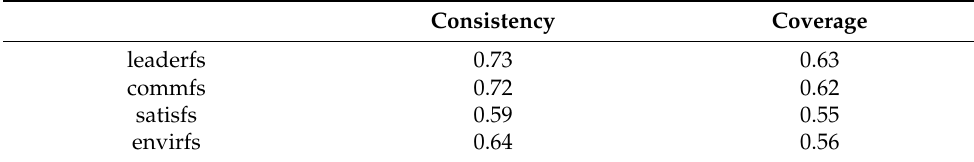
Table 3. Analysis of necessary conditions (outcome variable: perffs).